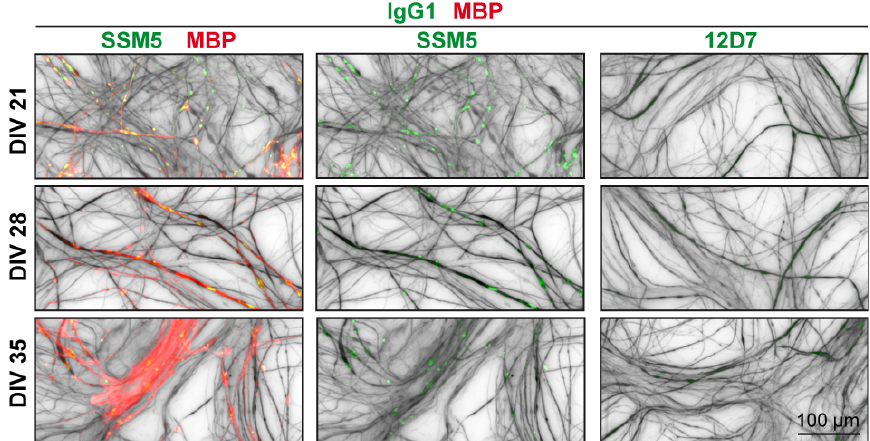
Figure 2. Immunofluorescence analysis of the reactivity of SSM5 in myelinating spinal cord cultures. SSM5 (green) antibodies target neurites, immunostained for NF200 (grey) and myelin structures (MBP, red). Note: dot-like immunostaining of neurites with SSM5 was observed prior to myelination (DIV21). Lack of immunoreactivity of non-CNS reactive isotype control (12D7). Scale bar: 100 μ m.